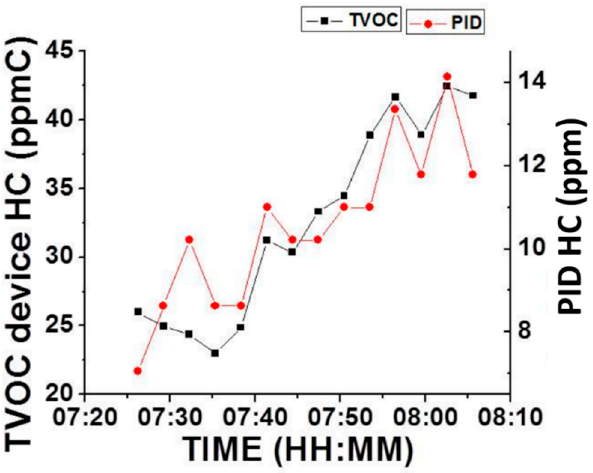
Figure 4. Comparison of the response between the new VOC (TVOC) device with a MIP-QTF sensor and RAE Photo-Ionization Detector (PID) for levels assessed during a trip on Los Angeles Highway 101. NOTE: The response of TVOC was calculated in ppmC using a calibration factor for “outdoor environment with motor vehicle exhaust” (see text for more details), while the response of PID was calculated in ppm using the calibration procedure described in the instrument manual.